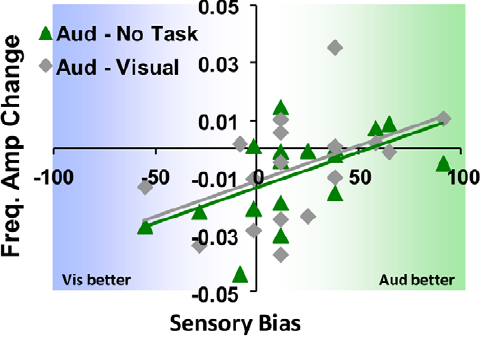
Figure 7. FFR change related to sensory bias. The degree of subjects’ sensory bias significantly predicts auditory task-related suppression in primary FFR frequency amplitude (relative to no task), such that those subjects that are more highly acute in the auditory domain show minimal or no suppression. Meanwhile, those whom display less bias or a proclivity more towards vision appear more susceptible to the suppressive effect. A similar trend occurs when comparing auditory against visual tasks, but not for visual above baseline, as well as with FFR pitch strength as the metric.